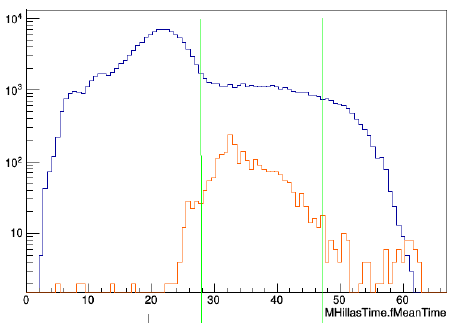
Figure 2. Distribution of the Hillas Mean time parameter (blue data, orange simulations). The green lines individuate identify the most e ffi cient cut as found by the application of the Genetic